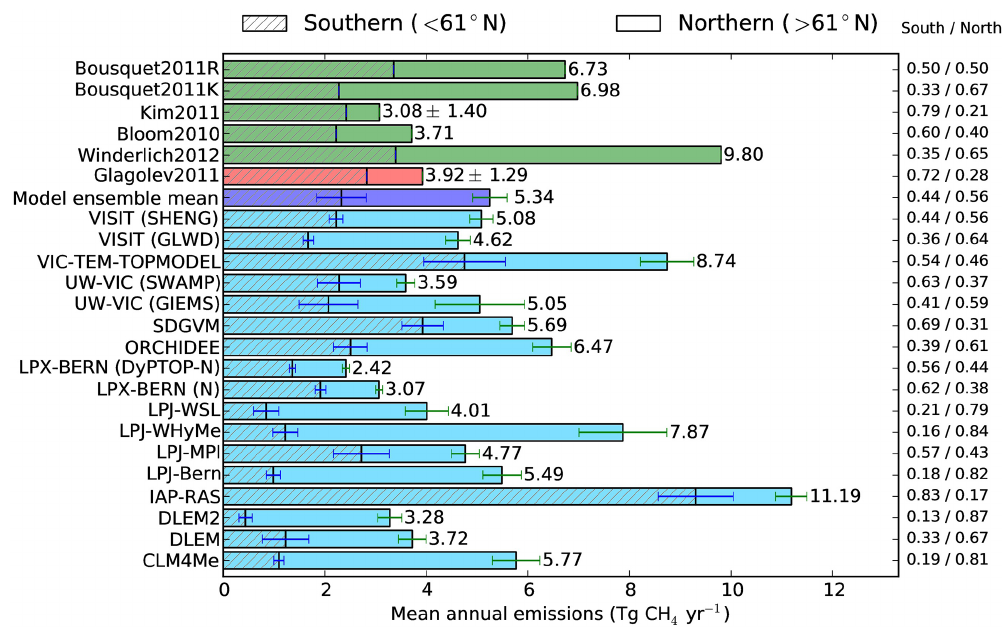
Figure 2. Mean annual emissions from the WSL: from inversions (green), observation-based estimates (red), and forward models (blue). The hatched portions of the bars indicate the emissions from the southern half of the domain (latitude < 61 ◦ N). Error bars on the model results indicate the interannual standard deviations of the southern and northern emissions. Error bars on the inversions and observational estimates indicate the uncertainty given in those studies. Numeric fractions of the total emissions contributed by the southern and northern halves of the domain are displayed in the right-hand